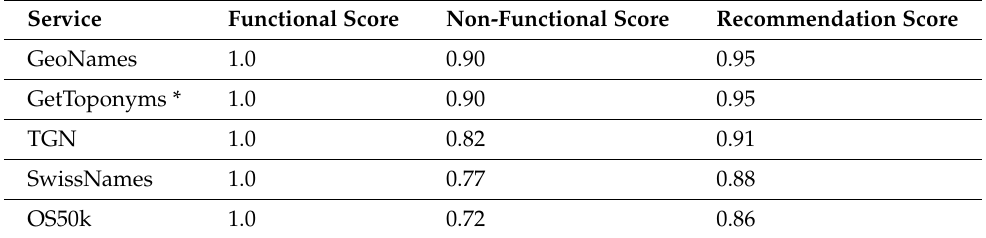
Table 8. Recommendation score associated to the request R2